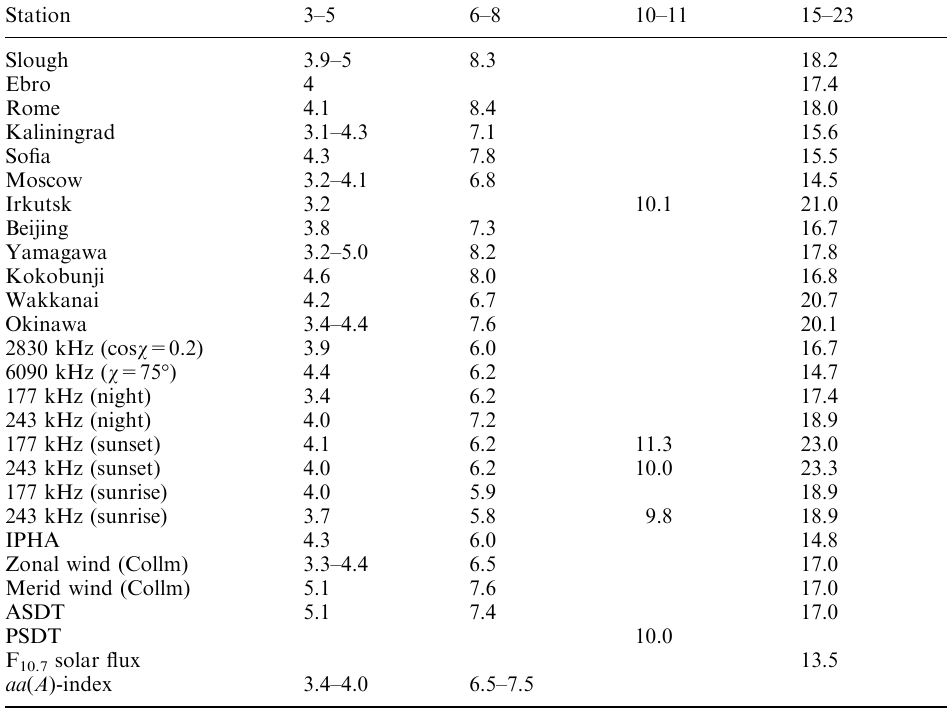
Table 3. Summary of domi- nant periods in the periodical bands: 3–5, 6–8, 10–11 and 15– 23 days, observed in f data, min A3 absorption and IPHA mea- surements, winds near 95 km (ASDT, PSDT – amplitude and phase of semidiurnal tide), solar (F ) and geomagnetic ( aa ) 10.7 activity